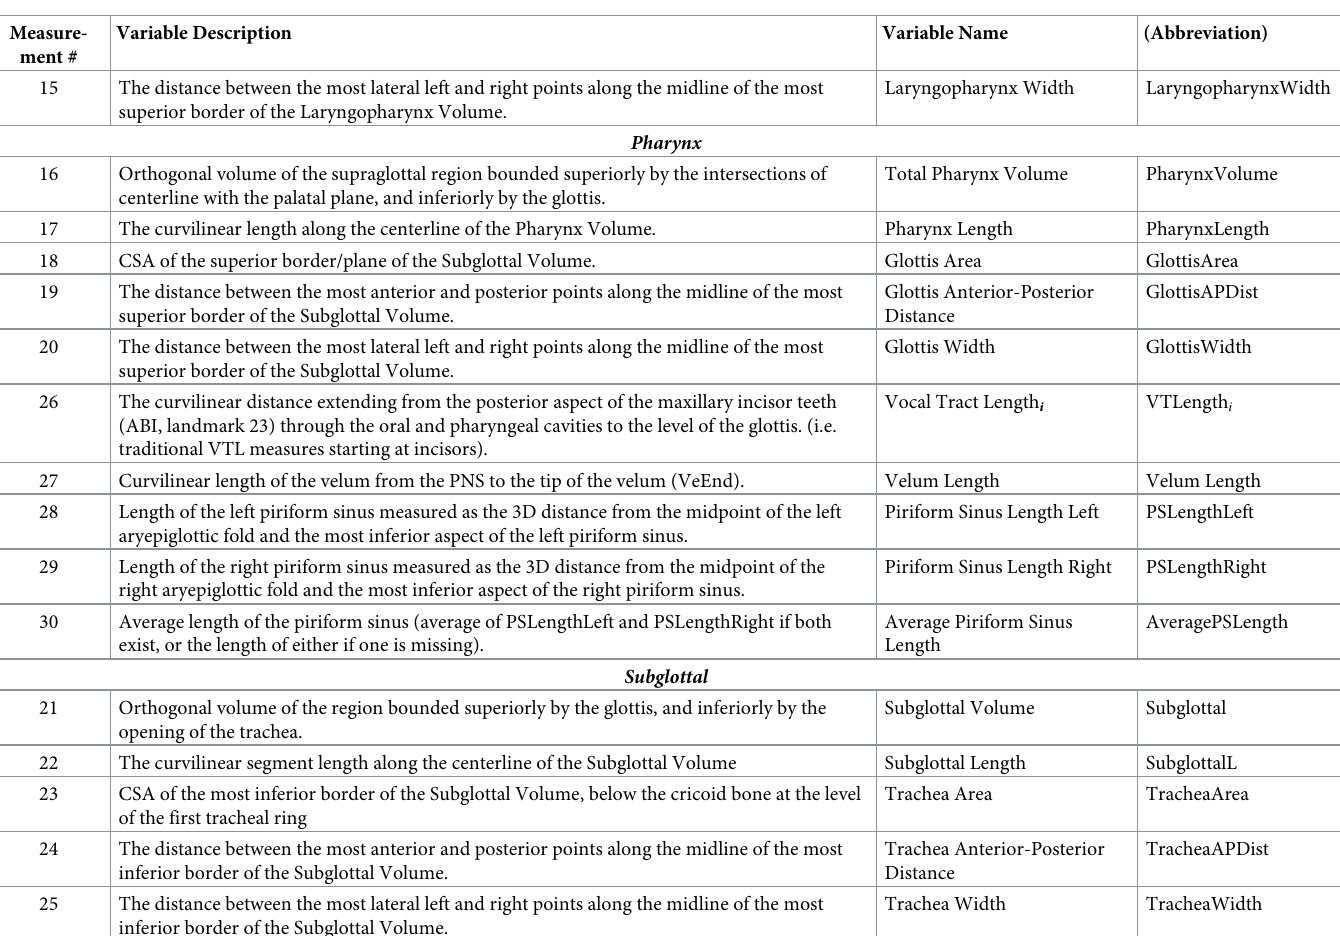
Laryngopharynx, and (iv) Subglottal. See Fig 1. Each subregion was isolated using its respective ‘landmark-derived planes’ orthogonal to the centerline using the following boundary defini- tions: The nasopharynx region was defined as an orthogonal volume bound by the intersection of the centerline with the palatal plane–formed by the anterior nasal spine (ANS) and posterior nasal spine (PNS) landmarks–superiorly, and with the tip of the velum inferiorly. The oro- pharynx region was defined as an orthogonal volume bound by the orthogonal planes at the tip of the velum superiorly, and by the aryepiglottic fold inferiorly. The laryngopharynx region, that includes the piriform sinuses, was defined as the orthogonal volume bound by the orthog- onal planes at the midpoint of the aryepiglottic folds superiorly (the most curved point at approximate halfway between the base and tip of the aryepiglottic folds), and by the glottis inferiorly. The subglottal region was bound superiorly by the inferior boundary of